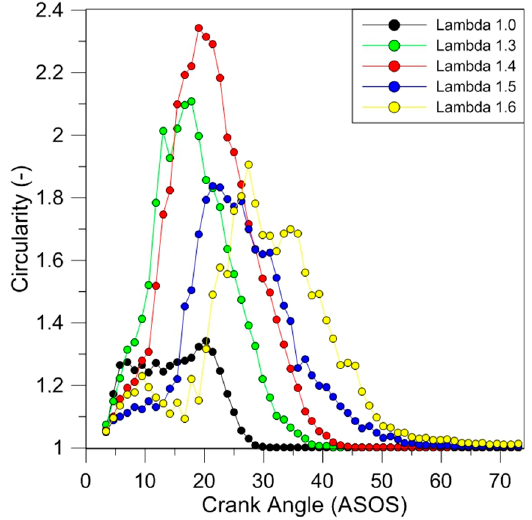
Figure 17. Evolution of the Heywood Circularity Factor, obtained by averaging data over 25 consecutive engine cycles.